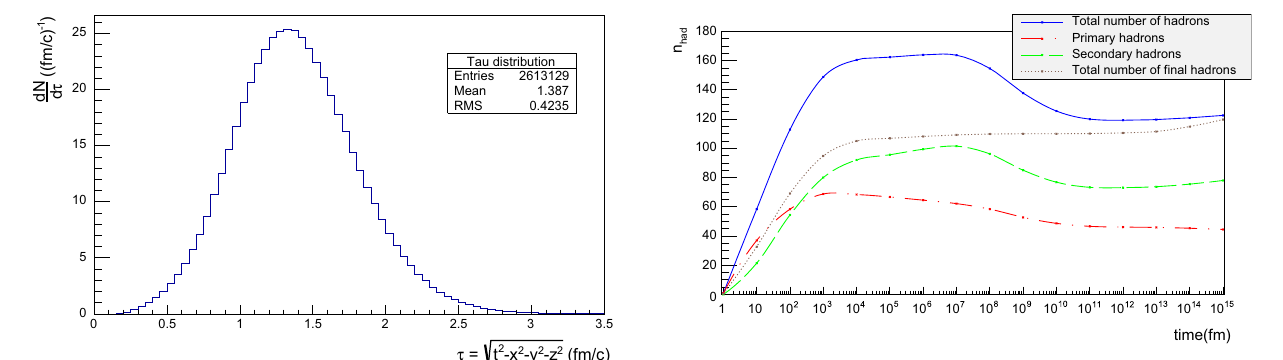
Most of the expansion of the system is along the z axis,